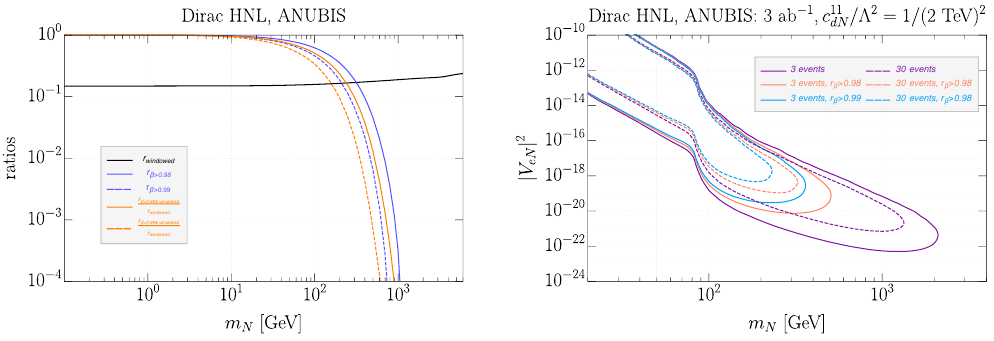
Figure 8 . Left panel: ratios of the number of HNLs in the ANUBIS direction to the total event number above a certain speed threshold, as a function of the HNL mass. Here, “windowed” means the fraction of HNLs traveling inside the ANUBIS solid-angle window without cuts on β , where β denotes the speed of the HNL. Two different β cuts are applied and compared in the plot. Right panel: sensitivity limits to the Dirac HNLs with the operator O 11 with and without timing cuts, dN for 3 or 30 signal